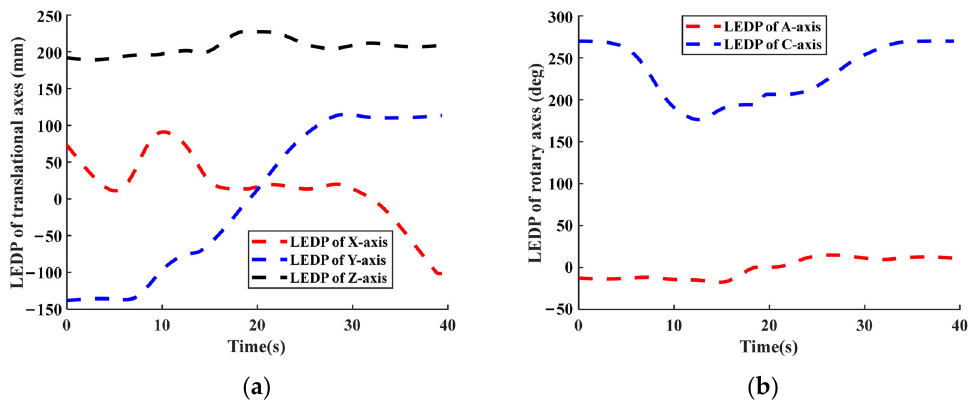
Figure 17. LEDP of each axis of the KMC400S U five ‐ axis machine tool. ( a ) LEDP of translational axes; ( b ) LEDP of rotary axes.